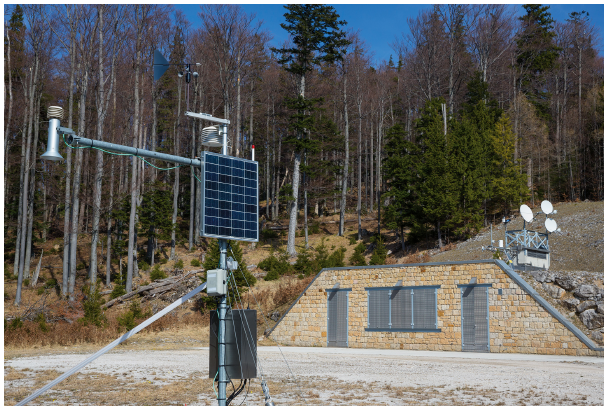
Figure 7. The Conrad Observatory – SGO (ZAMG,